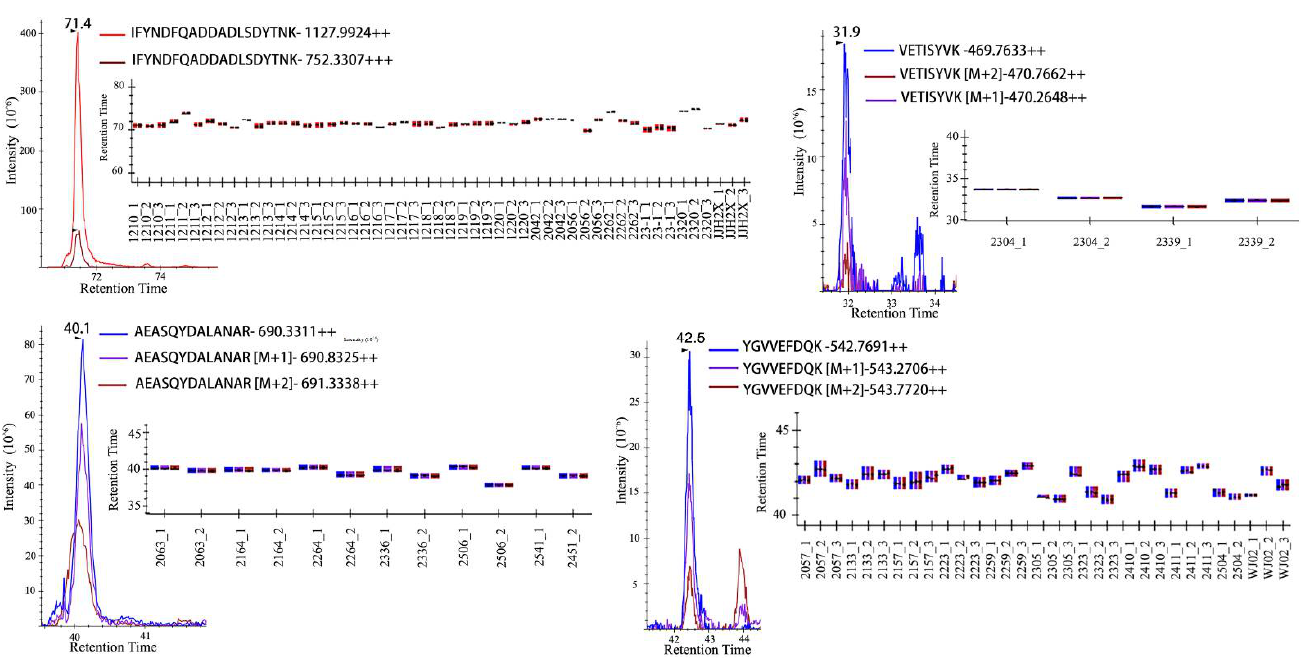
Figure 1. The parts of LC-MS/MS spectra of Salmonella enterica serovar-identifying peptide markers in training group.